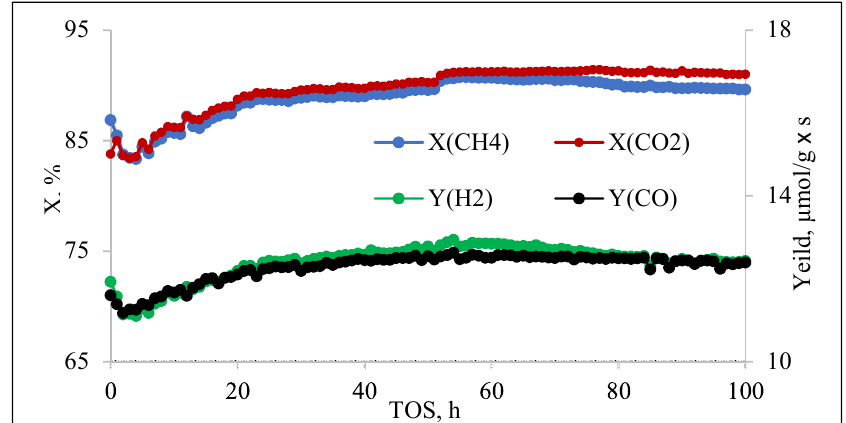
Figure 12. Dependence of CO 2 -CH 4 conversion and H 2 and CO yield on TOS in DRM over the 5%Co-Rh(98:2)/Al 2 O 3 at CH 4 :CO 2 :H 2 O = 1:1, t = 700 ◦ C, P = 1 atm, GHSV = 1000 h − 1 .